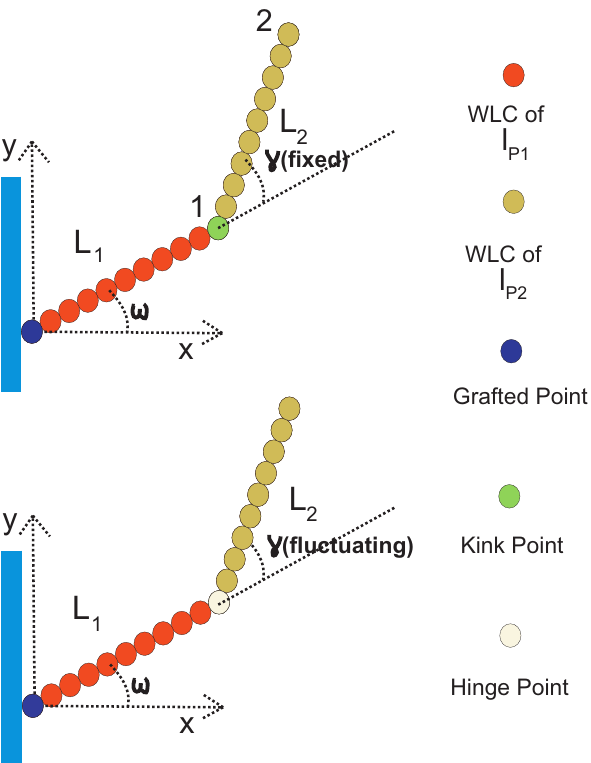
Figure 3. Upper panel: A configuration of two jointed weakly bending semiflexible filaments. The stiff joint (kink point) has a kink angle γ . The first filament has length L 1 and persistence length l p 1 . The second filament has length L 2 and persistence length l p 2 . The first filament is grafted on a substrate with a grafting angle ω . Lower panel: A configuration of two jointed semiflexible filaments with a hinged point. It differs from the system in the upper panel in that the kink angle γ fluctuates about an average value γ 0 . The hinge point has a rotational stiffness K h . For K h → ∞ , the hinge point becomes a kink point and we recover the upper panel